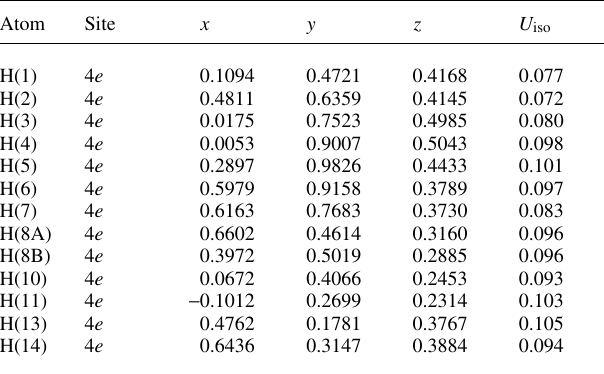
Table 2. Atomic coordinates and displacement parameters (in Å 2 )